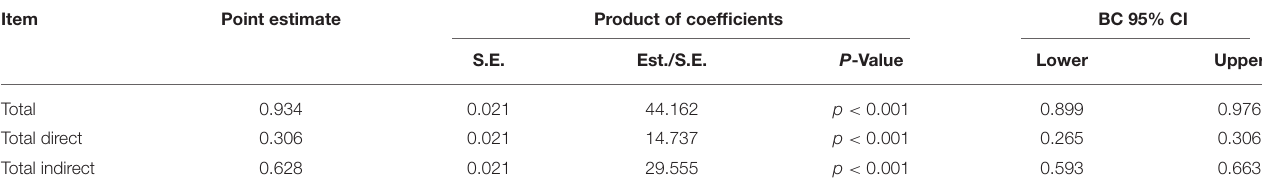
TABLE 6 | Indirect effect of WFC.